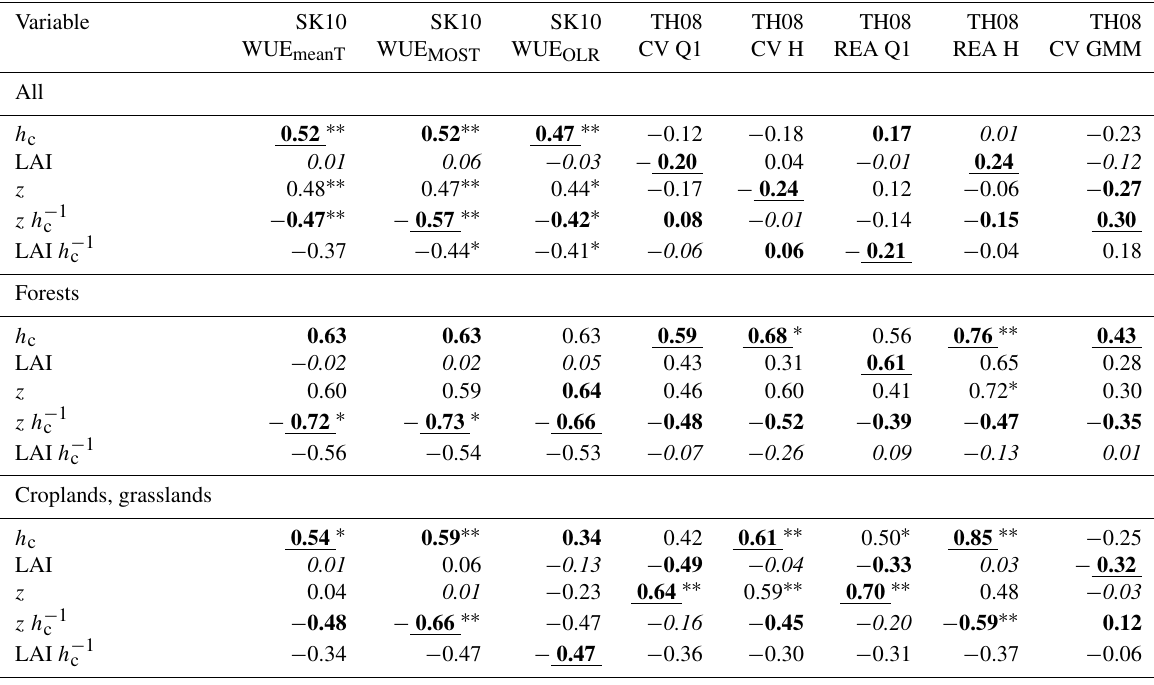
Table 3. Correlation coefficients between the partitioning performances of each method version regarding HiR TER (see text for descrip- tion) and study site characteristics ( h c : canopy height; LAI: leaf area index; z : measurement height) considering different sets of sites: all, only forest, or only cropland and grassland sites. Bold lettering indicates highest positive and highest negative correlation. Underlined let- tering indicates highest magnitude of correlation and italic lettering lowest magnitude of correlation. Also, the statistical significance of the correlations is indicated with ∗ p ≤ 0 . 1 and ∗∗ p ≤ 0 .